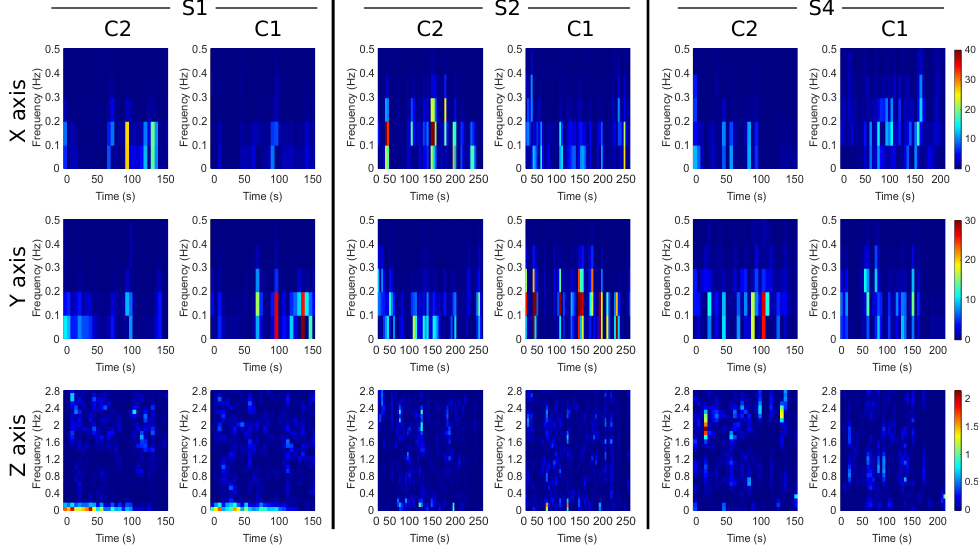
Figure 11. Spectrogram of the longitudinal ( x ), lateral ( y ) and vertical ( z ) axes (rows) of D1 driver with both cars (columns) when S1, S2 and S4 sections are considered